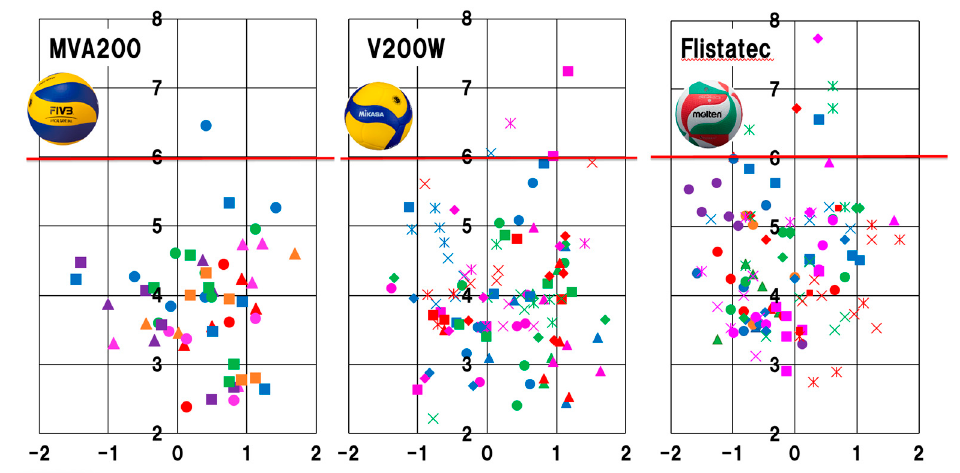
Figure 9. Landing point at 60 km/h for MVA200, V200W, and